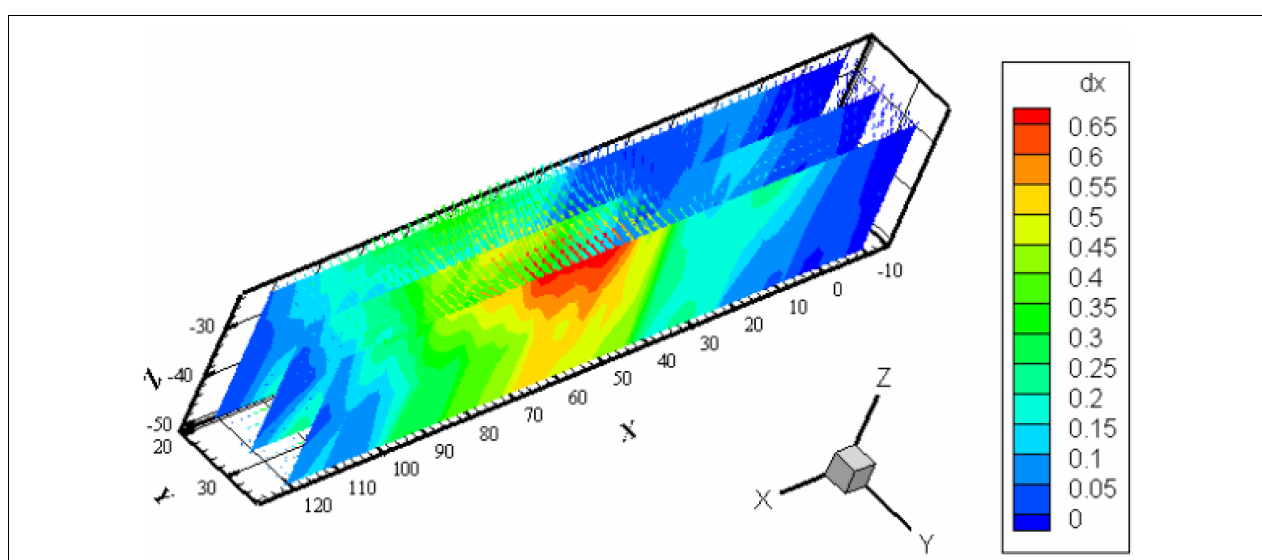
FIGURE 8 | 3D displacement field and contour plots of three slices of XZ